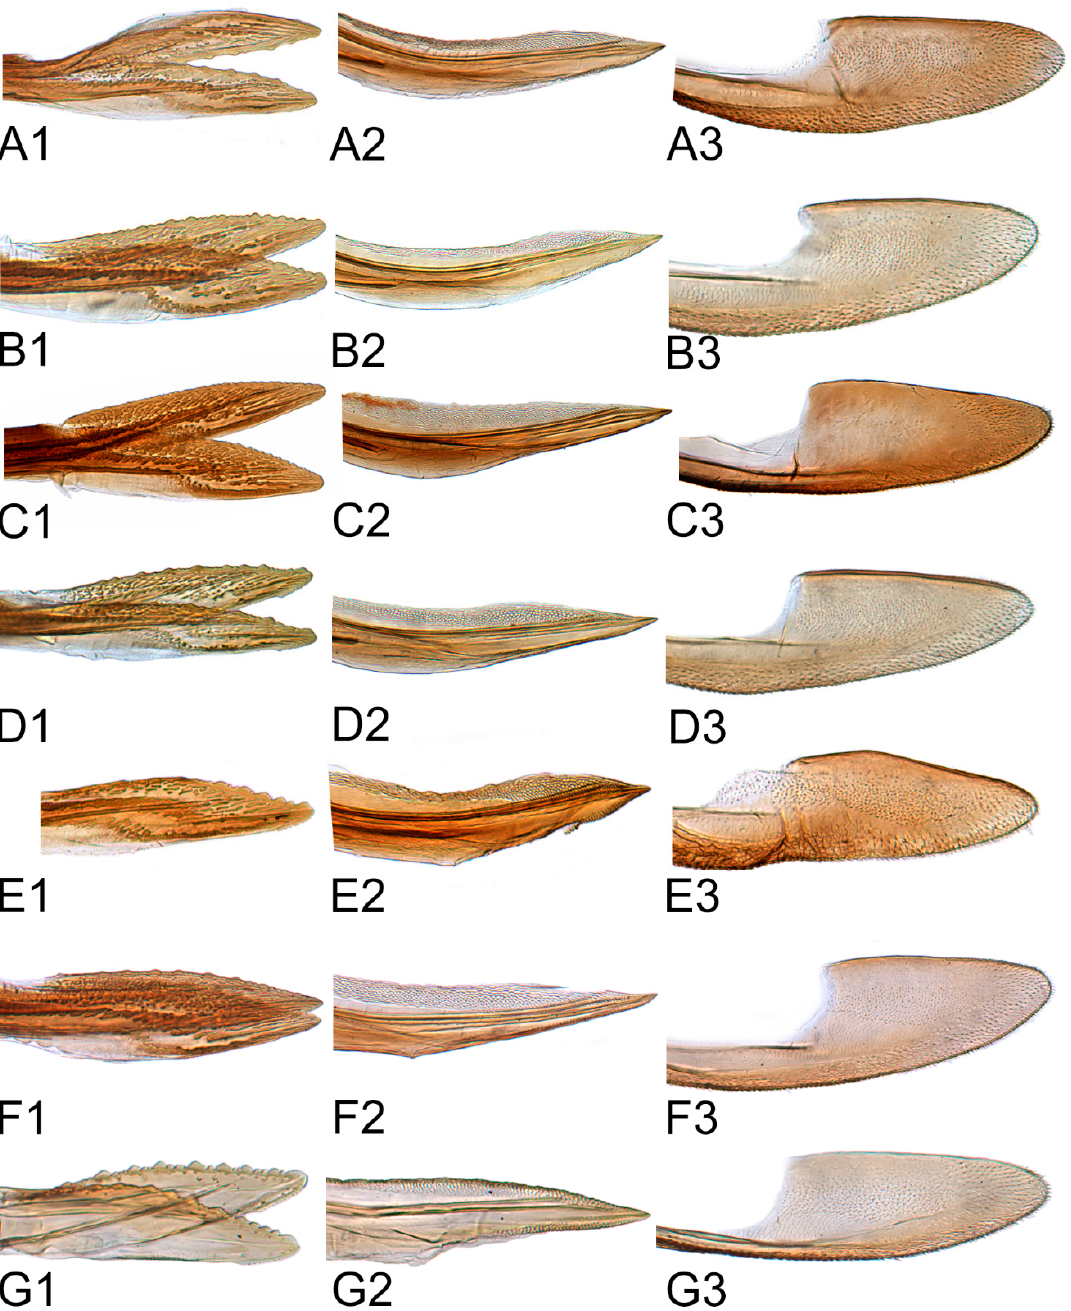
Figure 26. Dissected parts of ovipositor, showing detail of second, first, and third valvulae apex.